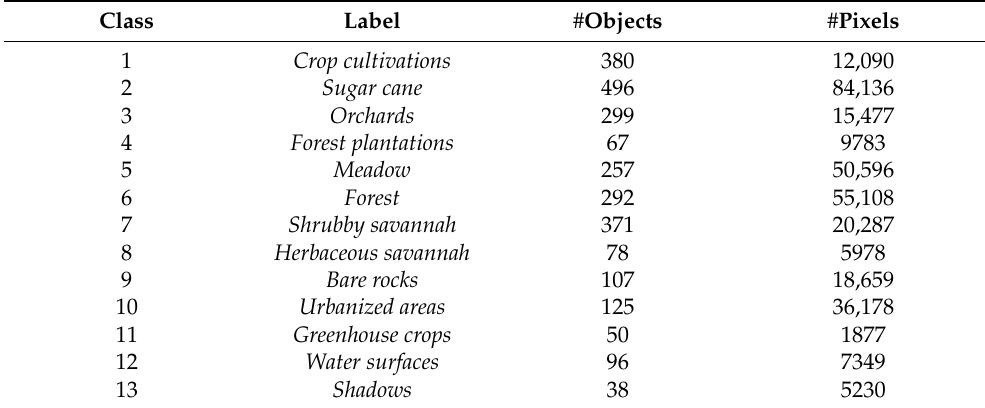
Table 1. List of labeled classes for Reunion Island with number of Objects (#Objects) and number of Pixels